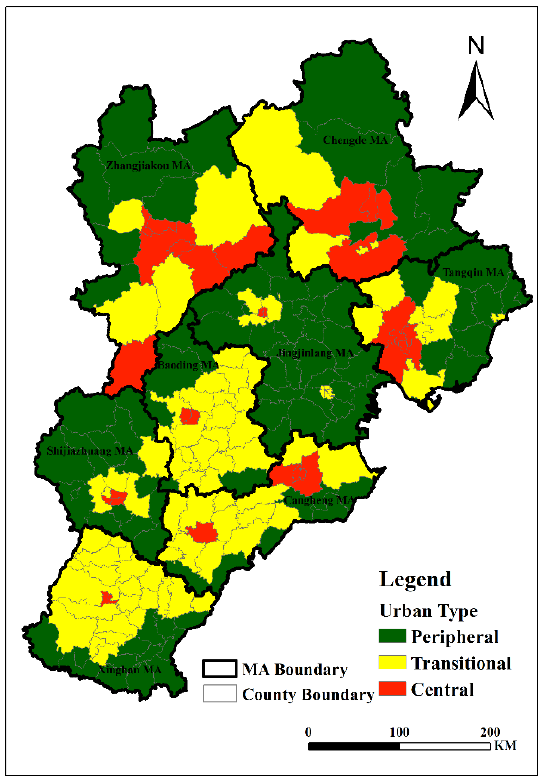
Figure 12. Judgment of potential core cities in the Beijing–Tianjin–Hebei metropolitan area: ( a ) Urban centrality level statistics; ( b ) number of urban centrality statistics.